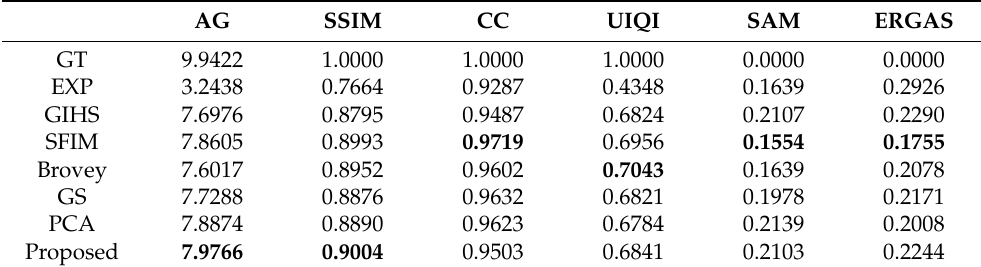
Table 5. Objective assessment indexes of the GFDM image fusion